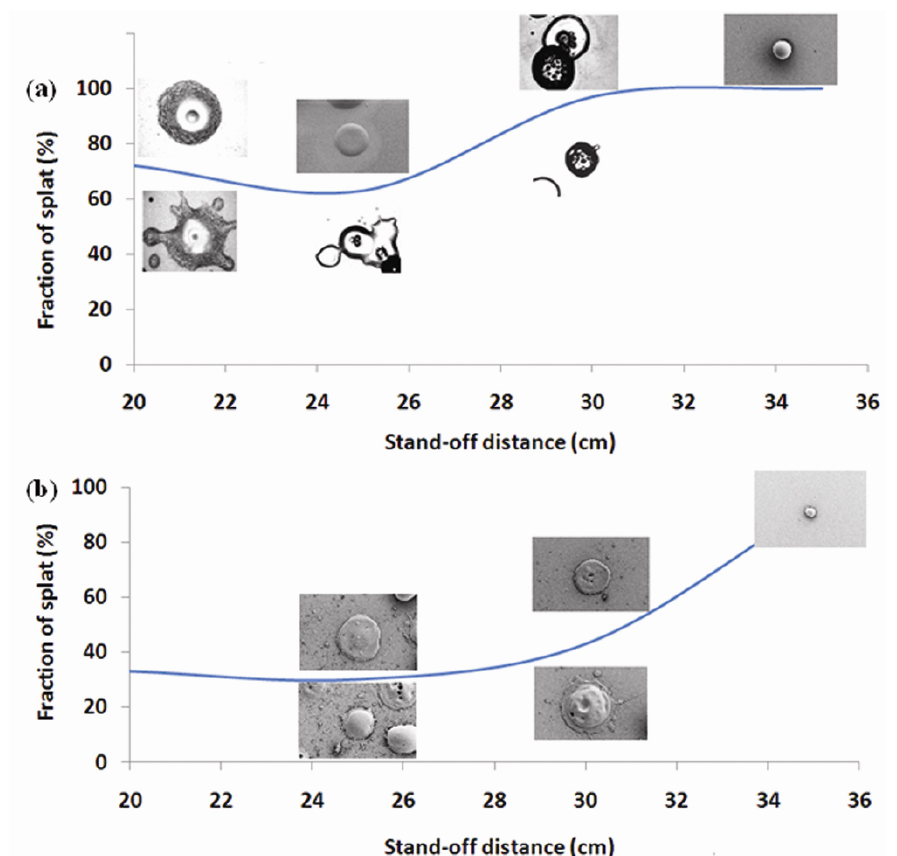
Figure 12. SOD effect on splat fraction of unheated ( a ) glass substrates and ( b ) mild steel